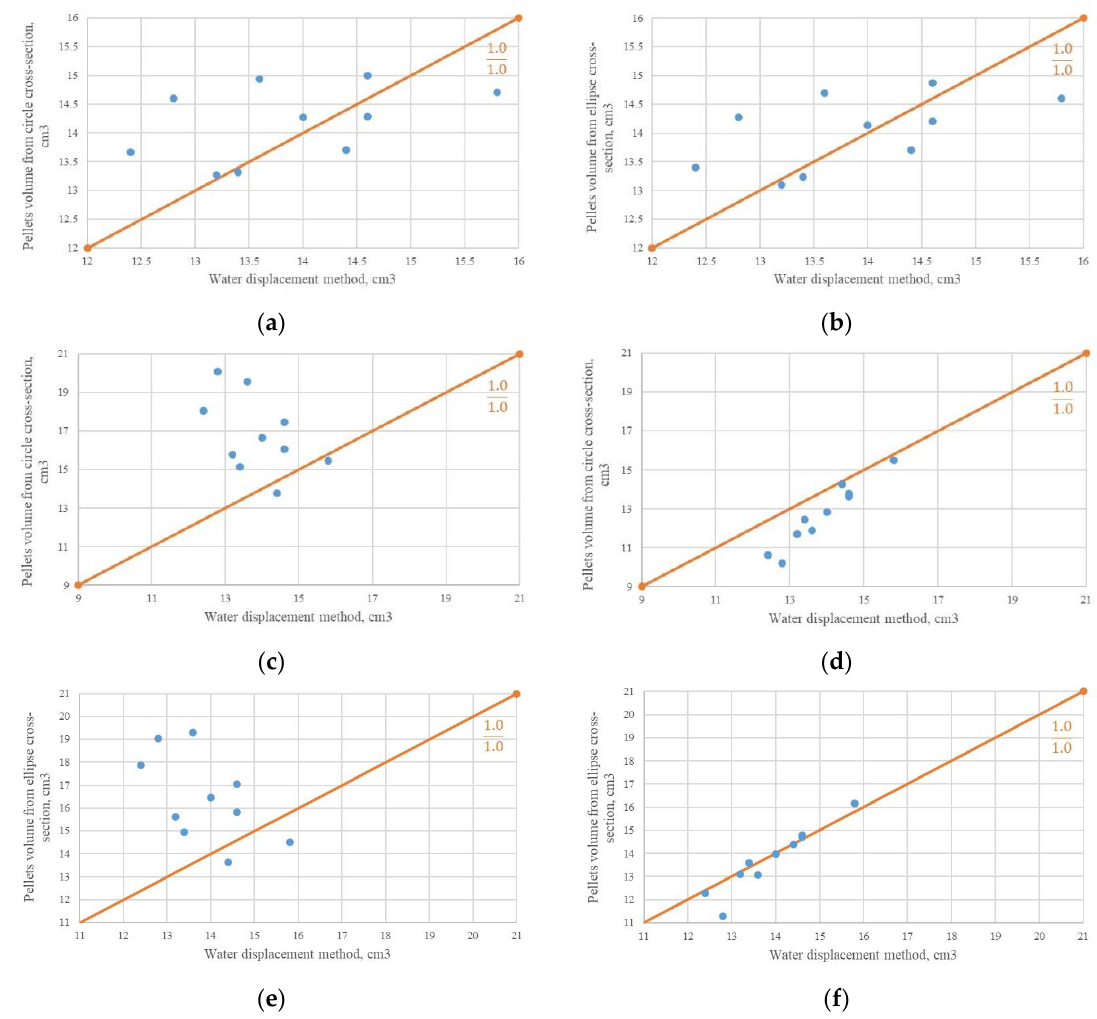
Figure 15. Measuring of volume of formed pellet models based on method of image processing. All